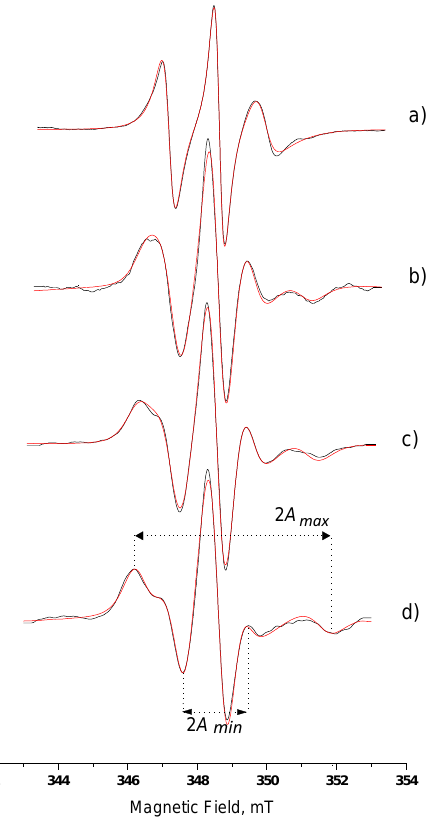
Figure 4. Spectra of 5-DSA in ( a ) AOT microemulsion w o = 15; ( b ) System A; ( c ) System B; ( d ) System C. Black line, experimental; red line, simulation. (A max and A min as described in the Supporting Information section).